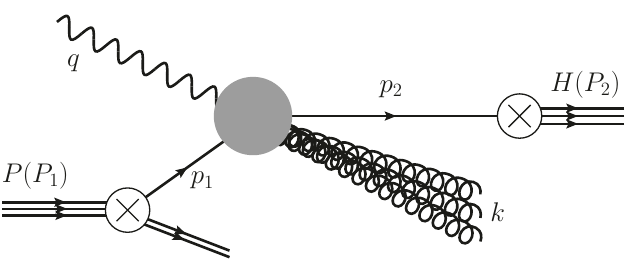
Figure 1 . Schematic picture of the DIS process in eq. (2.1), producing a final-state hadron H in the scattering of an electroweak boson, here a photon, off the incoming